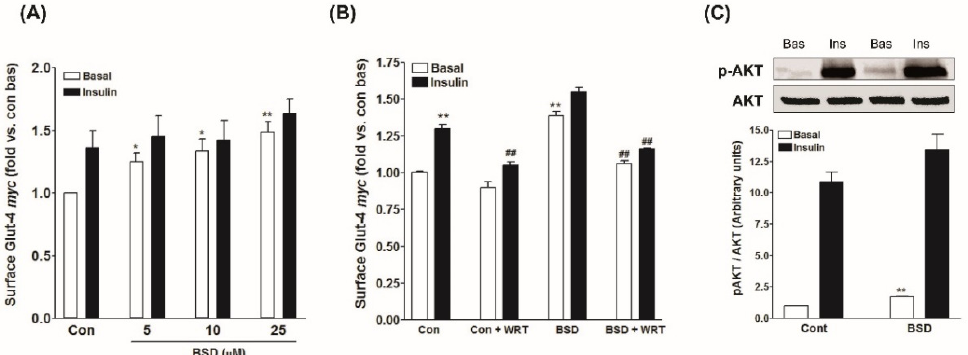
Figure 5. ( A , B ) Effect of BSD on translocation of GLUT4 to the plasma membrane in L6-GLUT4 myc myotubes. Cells were incubated for 16 h with increasing concentrations of BSD ( A ) or with 10 µ M of BSD for 16 h in the presence or absence of wortmannin ( B ). After incubation, cells were left untreated (white bars) or stimulated with 100 nM insulin for 20 min (black bars) after 3 h of serum starvation, followed by the determination of the proportion of GLUT4 myc at the cell surface. Results are expressed as fold stimulation over control basal. Results shown are mean ± SE of three independent experiments. * p < 0.05, ** p < 0.01 relative to control basal and ## p < 0.01 relative to respective wortmannin negative condition; ( C ) effect of BSD on phosphorylation of AKT (Ser-473) in L6-GLUT4 myc myotubes. Cells were incubated with BSD (10 µ M) for 16 h, then left untreated (white bar) or stimulated with insulin (100 nM) for 10 min, followed by cell lysis and Western analysis as described in the Materials and Methods section. Shown are representative immunoblots and densitometric quantification of phospho-AKT relative to total AKT. Results of three independent experiments are presented as mean ± SE. ** p < 0.01 relative to control basal.